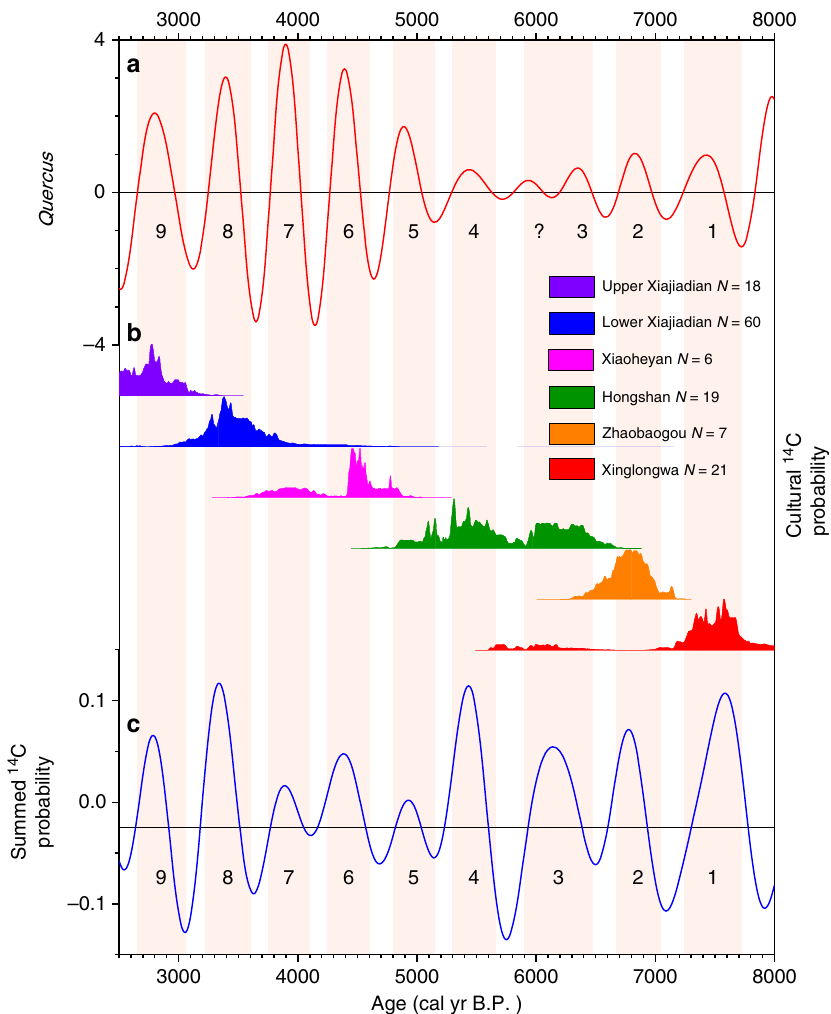
Fig. 5 Comparison of the detrended Quercus record (EASM proxy) with detrended 14 C probability. a 400 – 600-yr band-pass fi lter of the detrended Quercus record. The central frequencies and bandwidths of the Quercus percentages (EASM, c2-c5 component after HHT analysis) fi lters are 0.020 yr − 1 (500-yr period), 0.017 yr − 1 (600-yr period), and 0.025 yr − 1 (400-yr period), respectively. b Density histogram of cultural 14 C probability from prehistorical archeological sites; the 14 C-dated sites belong to the Xinglongwa, Zhaobaogou, Hongshan, Xiaoheyan, Lower Xiajiadian and Upper Xiajiadian cultures. c 400 – 1250-yr band-pass fi lter of the detrended SCP record. The central frequencies and bandwidths of the SCP (c2-c5 component after HHT analysis) fi lters are 0.020 yr − 1 (500-yr period), 0.008 yr − 1 (1250-yr period), and 0.025 yr − 1 (400-yr period), respectively. The two proxies (EASM and SCP)